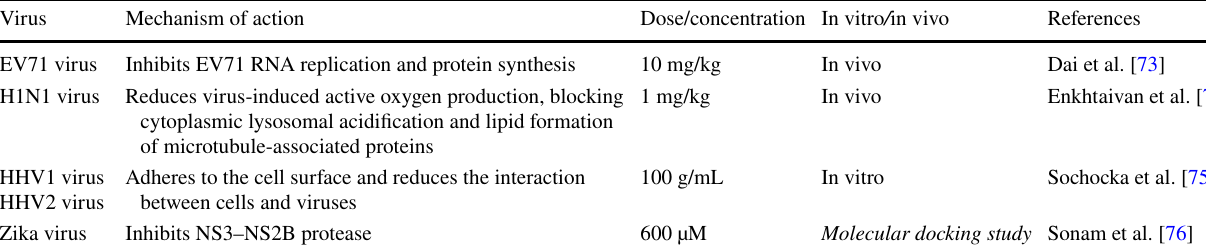
Table 6 Anti-virus activity of isorhamnetin Virus